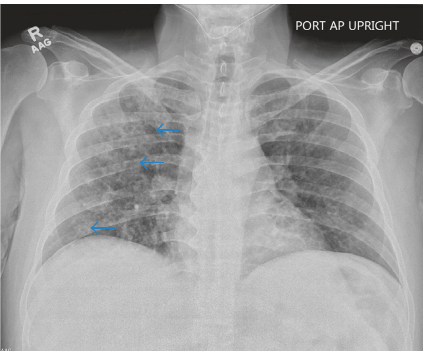
Figure 2: Chest roentgenogram on admission to our hospital. AP chest radiograph at presentation. Again seen are diffuse micronodules with confluent areas in the right upper and lower lungs. Hint of small cavities is again noted (blue arrows).